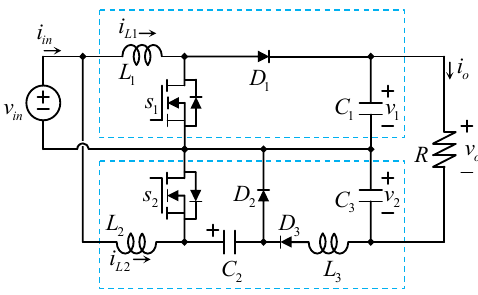
Figure 2. Configuration of the converter under study.